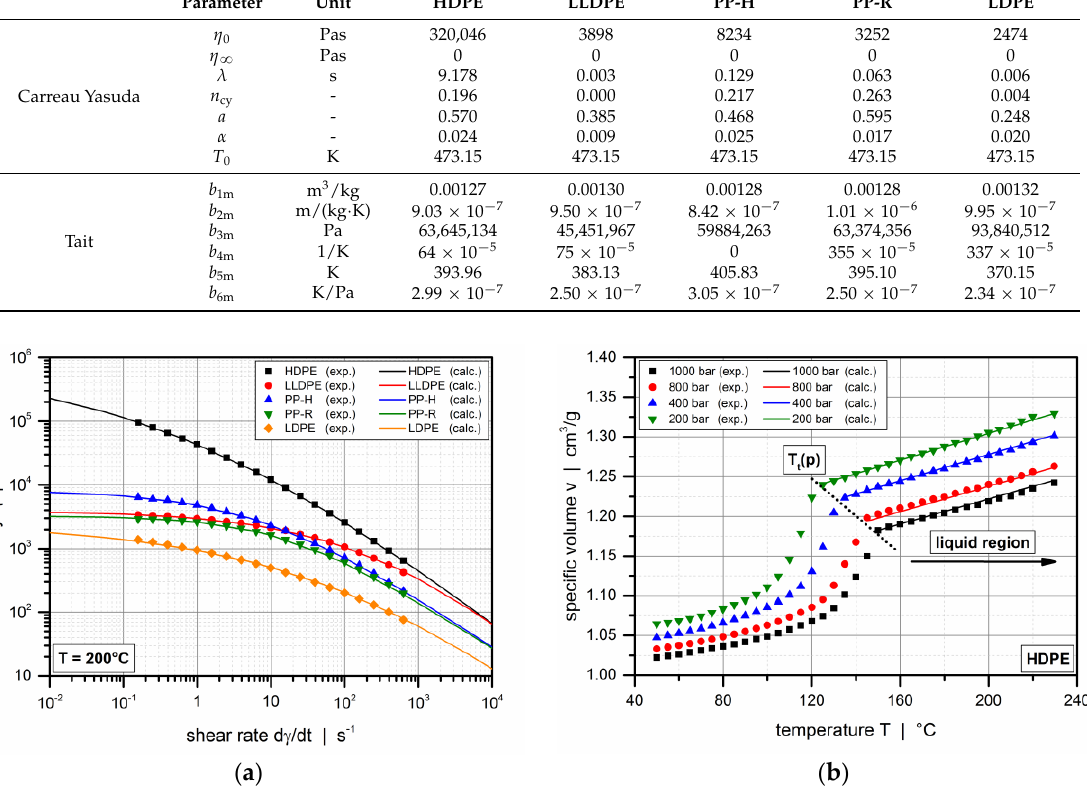
Figure 1. Comparison between experimental and calculated values: ( a ) Viscosity data of the polymer melts at temperature of 200 °C; ( b ) pressure-volume-temperature behavior of HDPE of pipe grade.